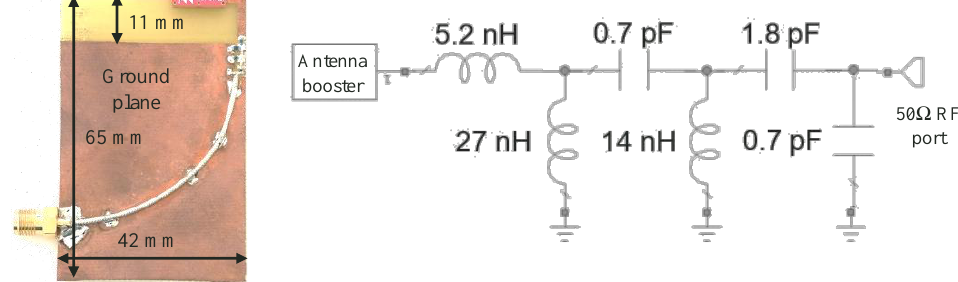
Figure 11. 12 mm × 3 mm × 2.4 mm (height) antenna booster on a 65 mm × 42 mm PCB (the ground